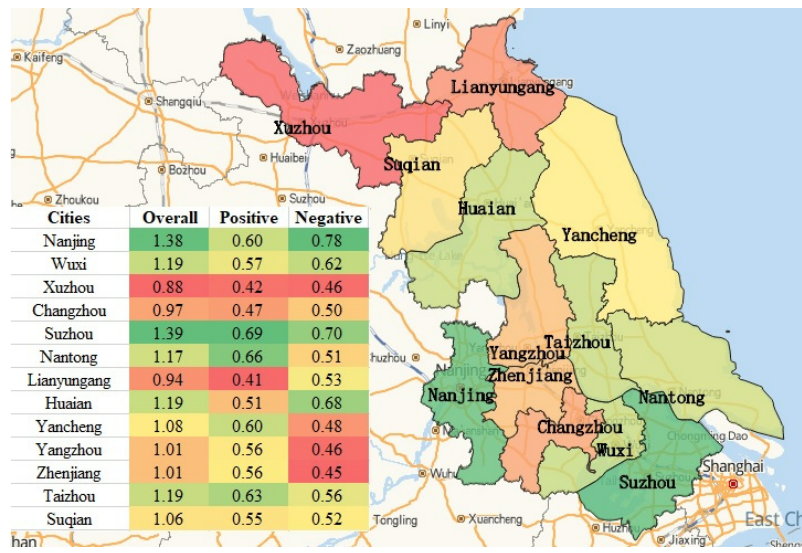
Figure 3. Status of externalities of highway infrastructures in the 13 cities of Jiangsu